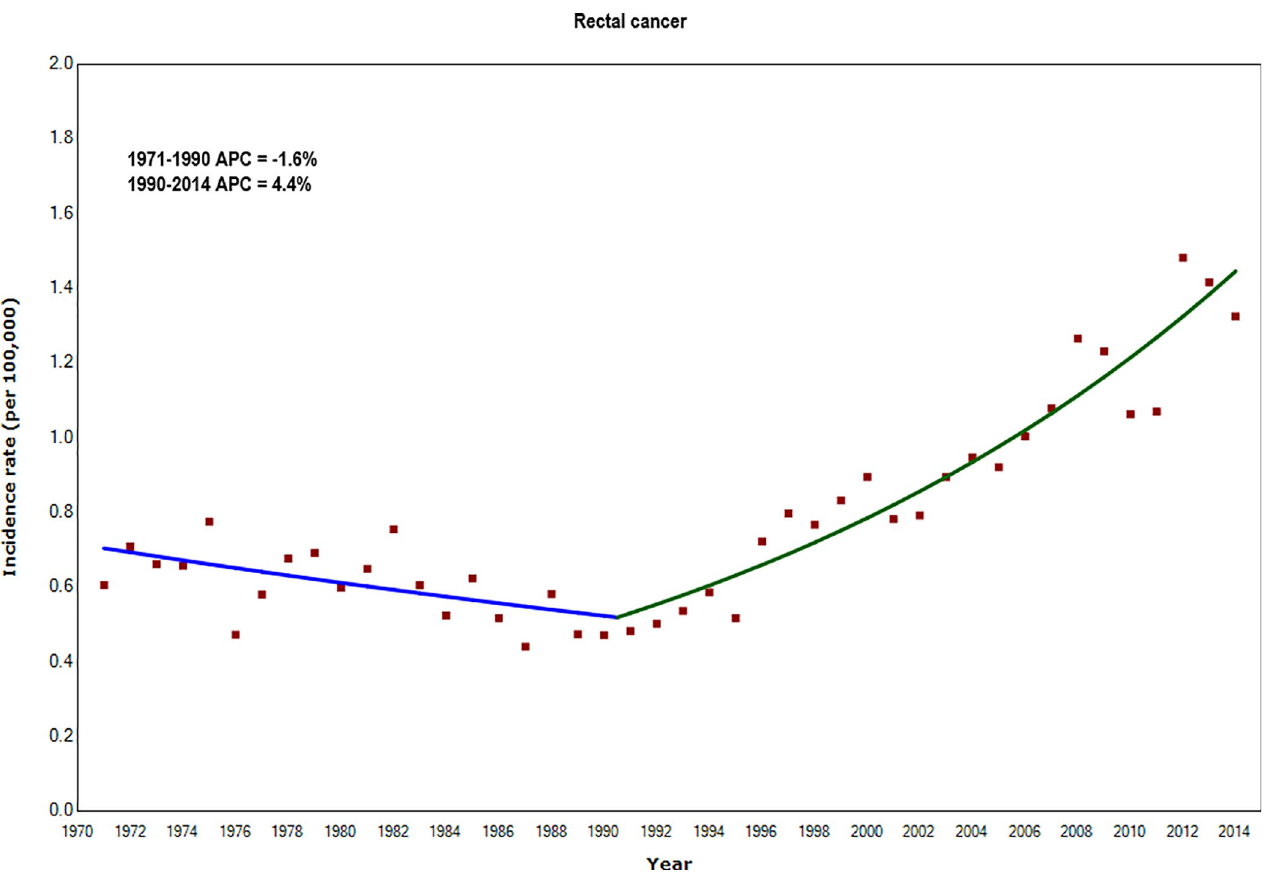
Fig 3. Annual Percentage Change (APC) in incidence rates of rectal cancer for adults aged 20–39 years: England